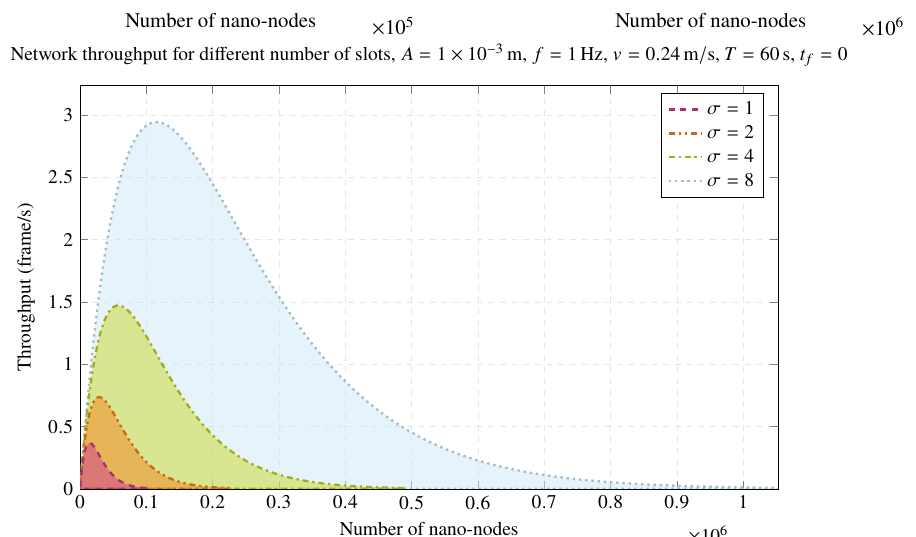
Figure 3. Impact of number of slots on network throughput for A = 1 × 10 − 3 m, f = 1Hz, v = 0.24m / s, T = 60s, and t f =